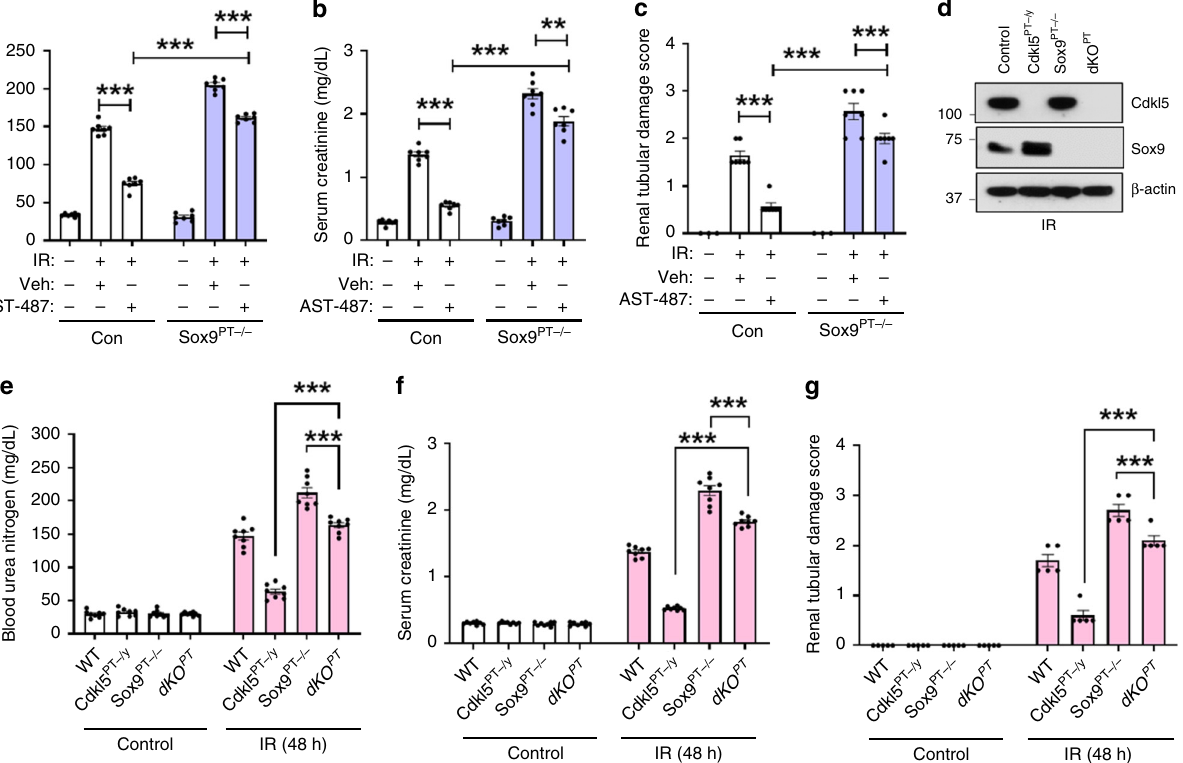
Fig. 7 Cdkl5 regulates AKI in a Sox9-dependent and -independent manner. Bilateral renal ischemic surgery was carried out in littermate control and Sox9 PT − / − mice, followed by administration of either vehicle or AST-487 (25 mg/kg, oral gavage, 6 h post IR). At 48 h, renal function and damage were assessed through measurement of a blood urea nitrogen, b serum creatinine, and c renal histological analysis (H&E). Age-matched WT, Cdkl5 PT − /y , Sox9 PT − / − , and Cdkl5 PT − /y Sox9 PT − / − (double-knockout mice indicated as dKO PT ) underwent bilateral renal ischemia for 30 min, followed by d Western blot analysis of renal tissues at 24 h post reperfusion (one out of two independent experiments) and assessment of renal structure and function at 48 h through measurement of e blood urea nitrogen, f serum creatinine, and g renal histological analysis (H&E). Data presented ( a – c , e – g ) are cumulative of three independent experiments ( n = 6). In all the bar graphs, experimental values are presented as mean ± s.e.m. The height of error bar = 1 s.e. and p < 0.05 was indicated as statistically signi fi cant. One-way ANOVA followed by Tukey ’ s multiple-comparison test was carried out, and statistical signi fi cance is indicated by * p < 0.05, ** p < 0.01, *** p < 0.001. Source data are provided as a Source Data fi